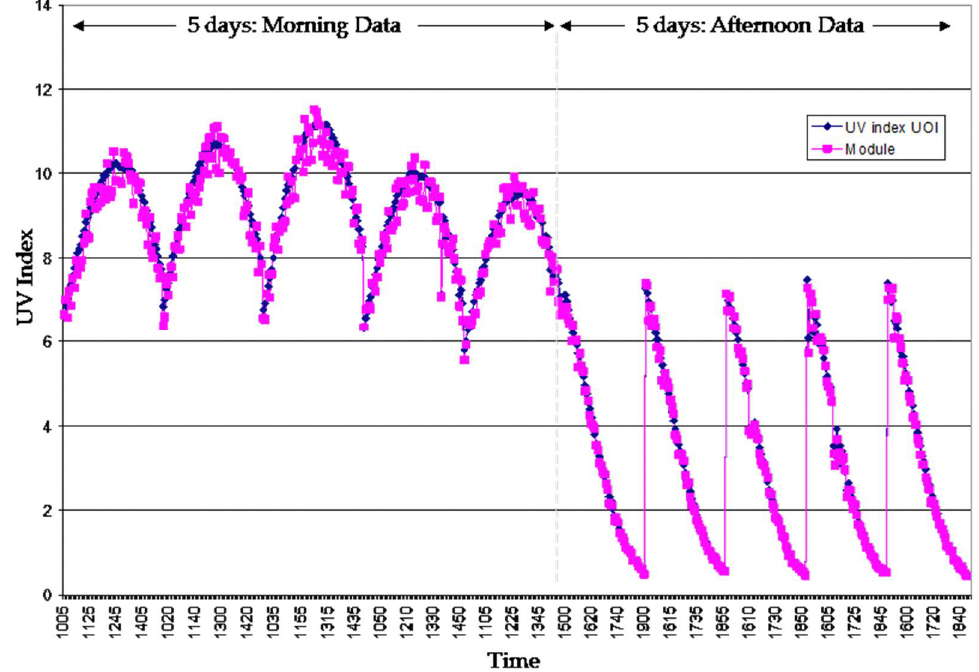
Figure 5. The UV index (UVI) data obtained from a ground-truth station (UV index University of Ioannina (UOI)) and the sensing device (module).